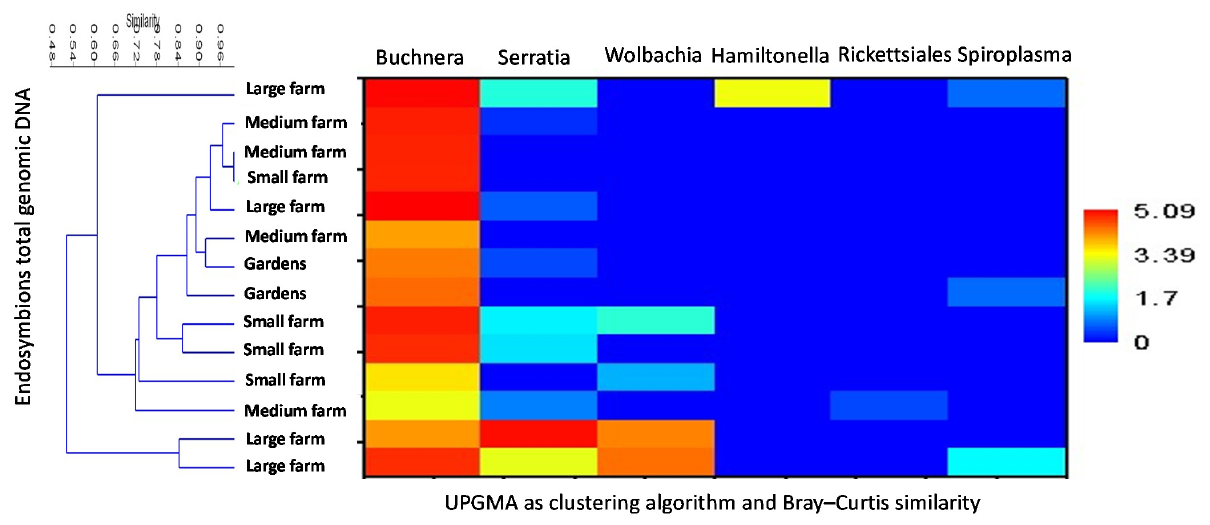
Figure 2. Relative abundance patterns of the endosymbiotic taxa present on all maize fields using UPGMA as clustering algorithm and Bray–Curtis similarity calculation. Endosymbiontic taxa were sorted by their abundance (total genomic DNA) to the differentiation between managements systems. Data are shown for taxa with >0.1% contribution. Blue colours represent no frequency, green a low frequency, yellow medium frequency and red high frequency. PCAs revealed the proportion of variation per each PCA axis (bacterial DNA diver- sity as axis 1, management systems as axis 2), which were explained by the most frequent obligate and facultative bacterial distribution. When the obligate and most dominant sym- bionts Buchnera are considered, the total DNA diversity represented 72% of the total, whereas management systems only represented 16.3% (Figure 3A). When only facultative symbionts were considered, the effect of management systems define distributions at a level of around 23.3%, while total DNA diversity define distributions at 43.8% (Figure 3B).